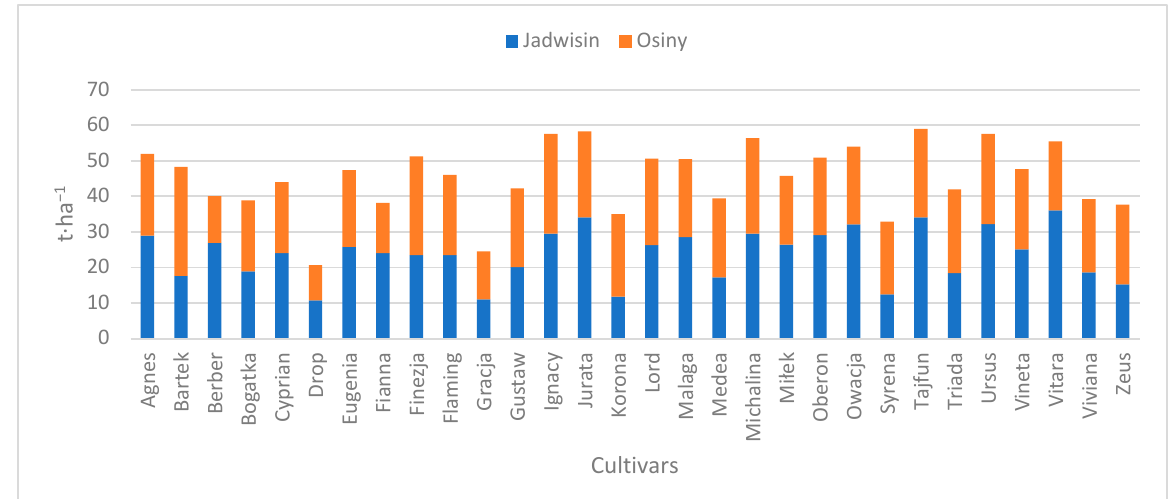
Figure 3. Yield of cultivars depending on site of growing (mean for 3 years).